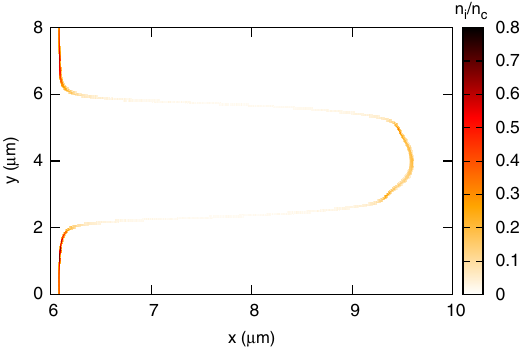
FIG. 5. Density distribution of protons at instant 21 T